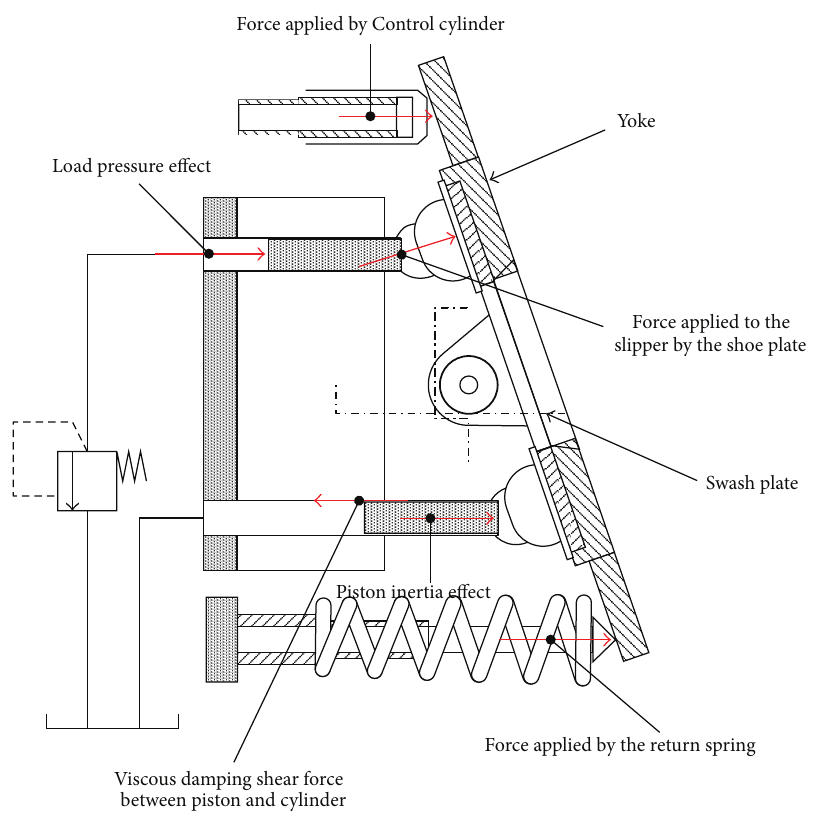
Figure 15: Various forces acting on the control cylinder [9, 12,